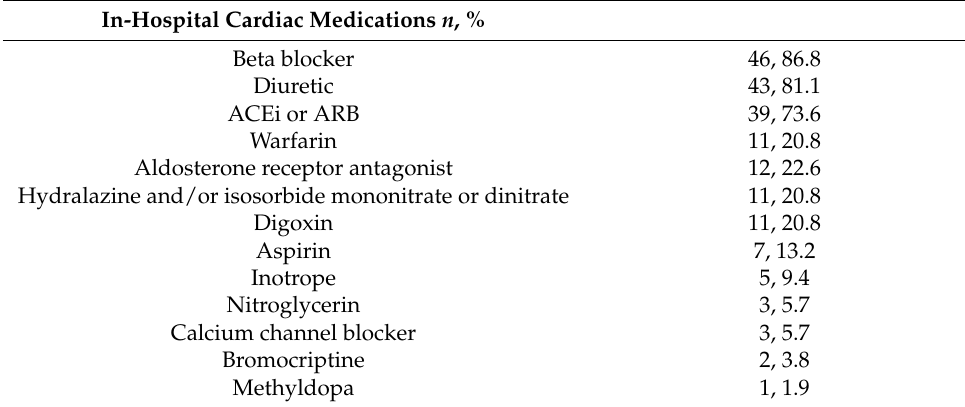
Table 3. In-hospital cardiac medications for women diagnosed with PPCM ( n =